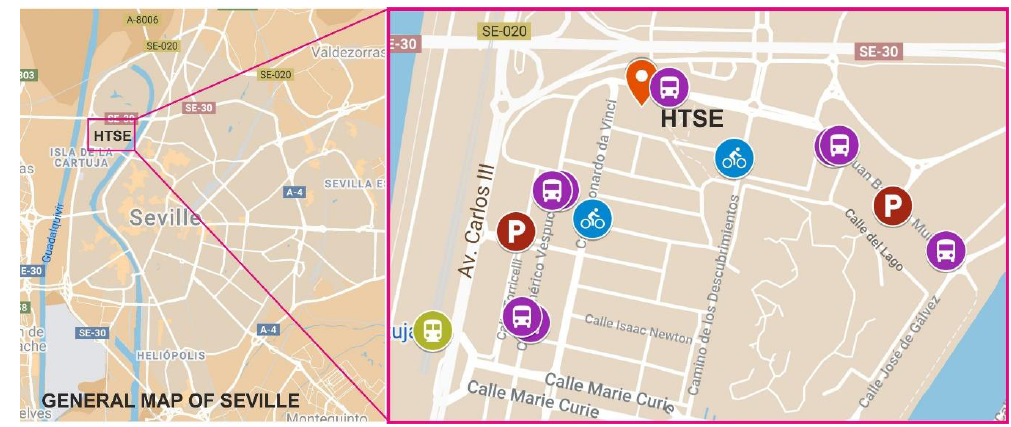
Figure 12. Georeferenced analysis of the HTSE campus [32,33].